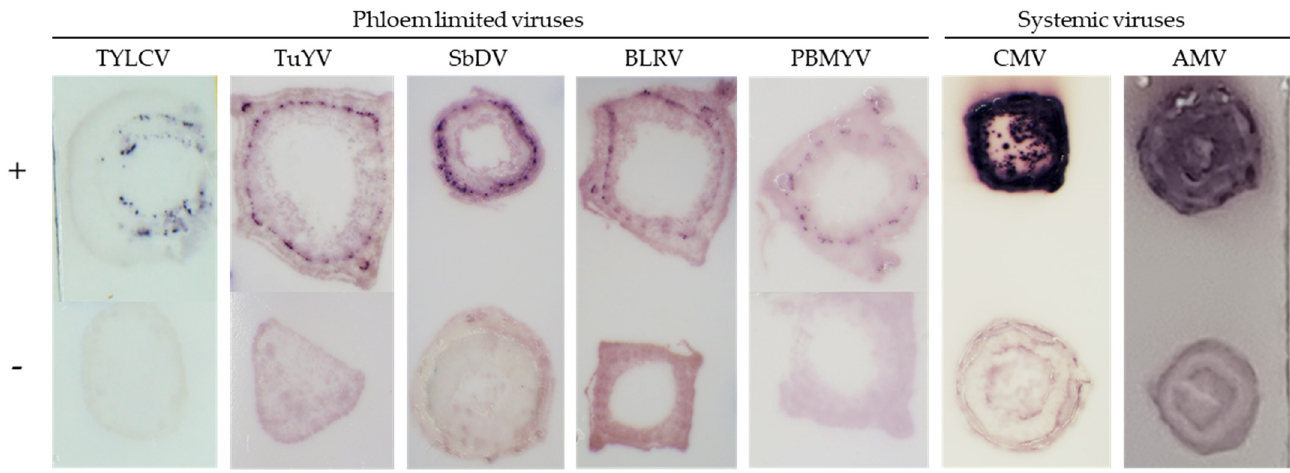
Figure 4. The TB-HCR targeting different viruses. Phloem limited viruses: TYLCV positive (+) blots and healthy negative control ( − ) blots were processed using DNA probes TYLCV-P1, TYLCV-P3 and TYLCV-P4 and the biotin labeled hairpins. Small purple spots in the phloem region were only observed on the TYLCV positive blots. Positive blots for TuYV, SbDV, BLRV, PBMYV and the healthy controls were processed using probes HCR-A1, HCR-A2, HCR-A3, TuYV-PR2, TuYV-PR3, PBMYV-PR2, PBMYV-PR3, BLRV-PR3, SbDV-PR2, SbDV-PR3, and the biotin labeled hairpins. Small deeply purple spots in the phloem region were observed only on the positive blots. Systemic viruses: positive blots for CMV and the healthy controls were processed using all CMV-SG1 and CMV-SG2 probes and the biotin labeled hairpins. Positive AMV blots and controls were probed with AMV-CP-PR1, AMV-CP-PR2, AMV-MP-PR1, and biotin labeled hairpins. For both CMV and AMV, a deep purple color across the whole blot was observed only for the positive blots. Note: Streptavidin and AP staining can faintly stain the background of some plant blots. This faint staining is not a positive reaction, positive reactions are indicated by a deep purple color.